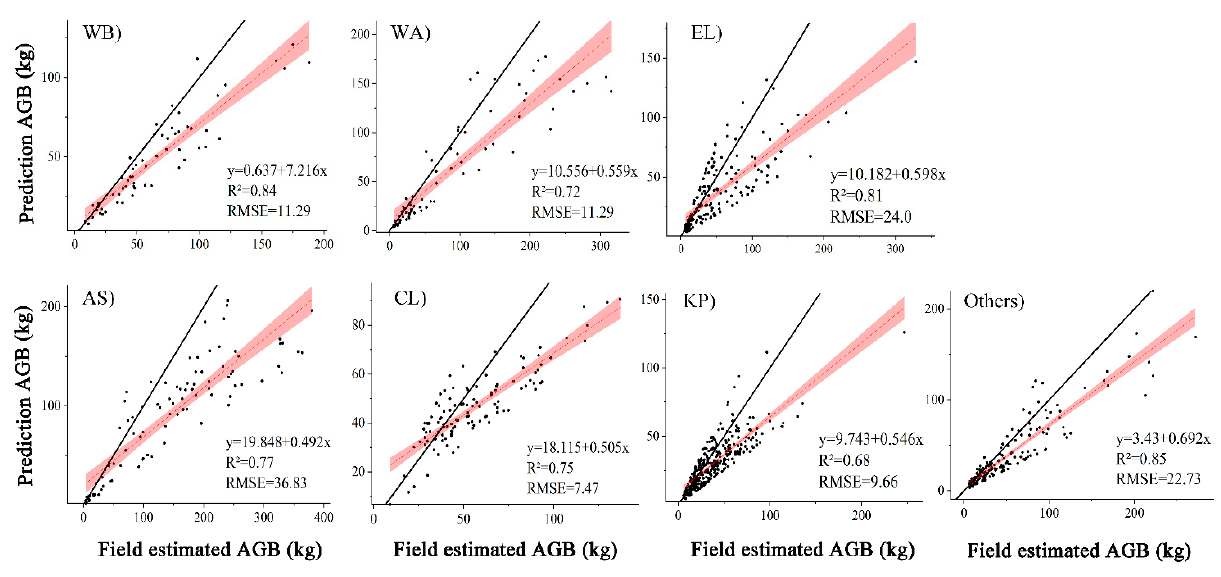
Figure 8. Accuracy comparison of individual tree AGB between field-observed estimation and remote sensing data estimation. Shaded areas represent 95% confidence intervals, and solid lines are the 1:1 line.